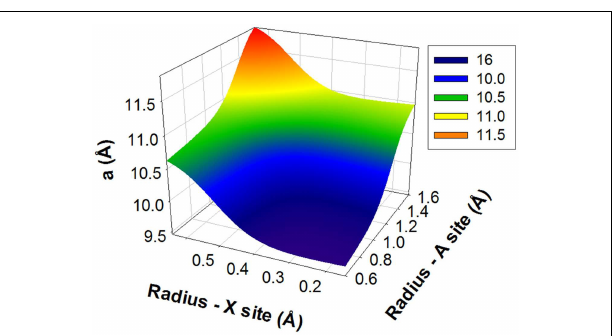
correspond to Y = T when the predicted and actual are the same. The solid lines correspond to linear fitting with a fitting coefficient of R. Open circles are experimental data. (A,B) are the result of training, (C,D) are of testing, and (E,F) are of the total.